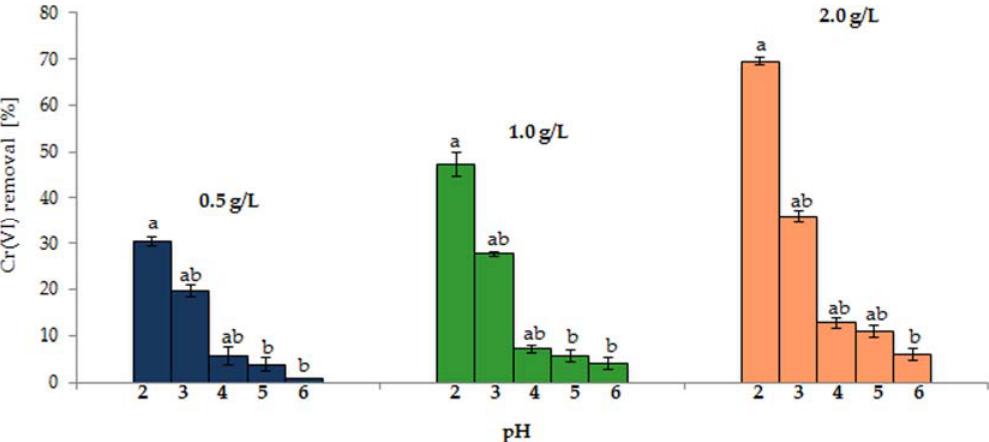
Figure 2. Influence of pH on the percentage of chromium(VI) removal from the solution by microalga Pseudopediastrum boryanum var. longicorne . Biosorption conditions: initial metal concentration 10 mg/L, biosorbent concentration 0.5, 1.0 and 2.0 g/L, temperature: 22.0 ± 1.0 °C. Presence of the same letter index indicates the lack of statistically significant difference ( p > 0.05).